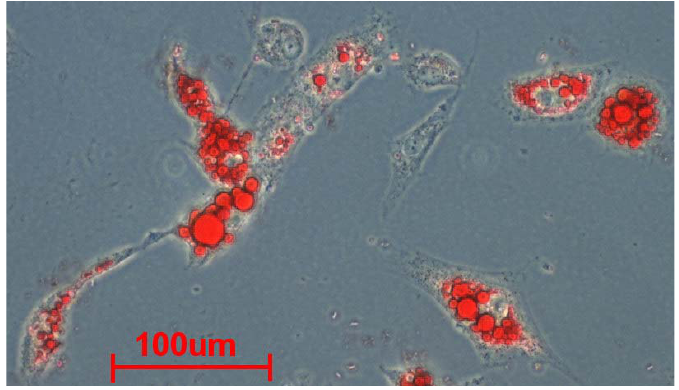
Fig. 1 – Oil red staining of the cells after 14 days of the beginning of adipogenic differentiation showing accumulated lipid vesicles in the